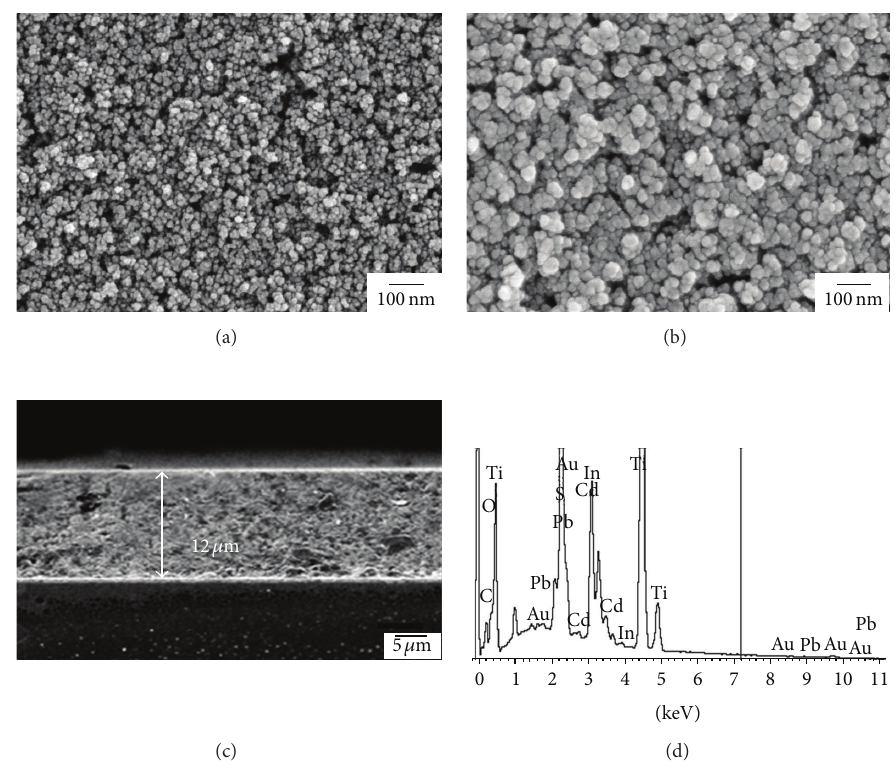
Figure 1: SEM image of (a) a bare TiO 2 mesoporous film and (b) In-PbS/In-CdS sensitized TiO 2 mesoporous film; (c) a cross-section SEM image of a bare TiO 2 film; (d) the EDX spectra of In-PbS/In-CdS QD sensitized TiO 2